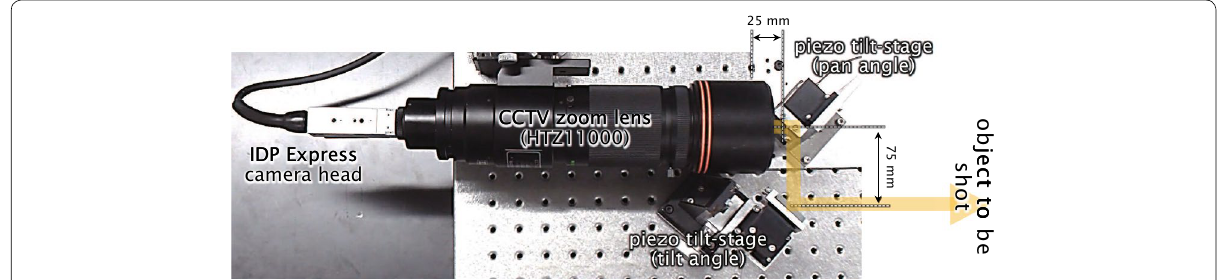
Fig. 4 Overview of motion-blur-free video-shooting